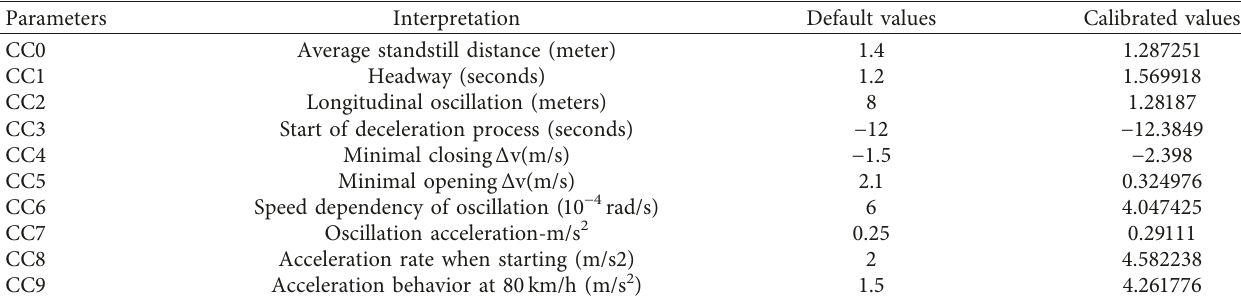
Table 3: GA calibrated W99 parameter